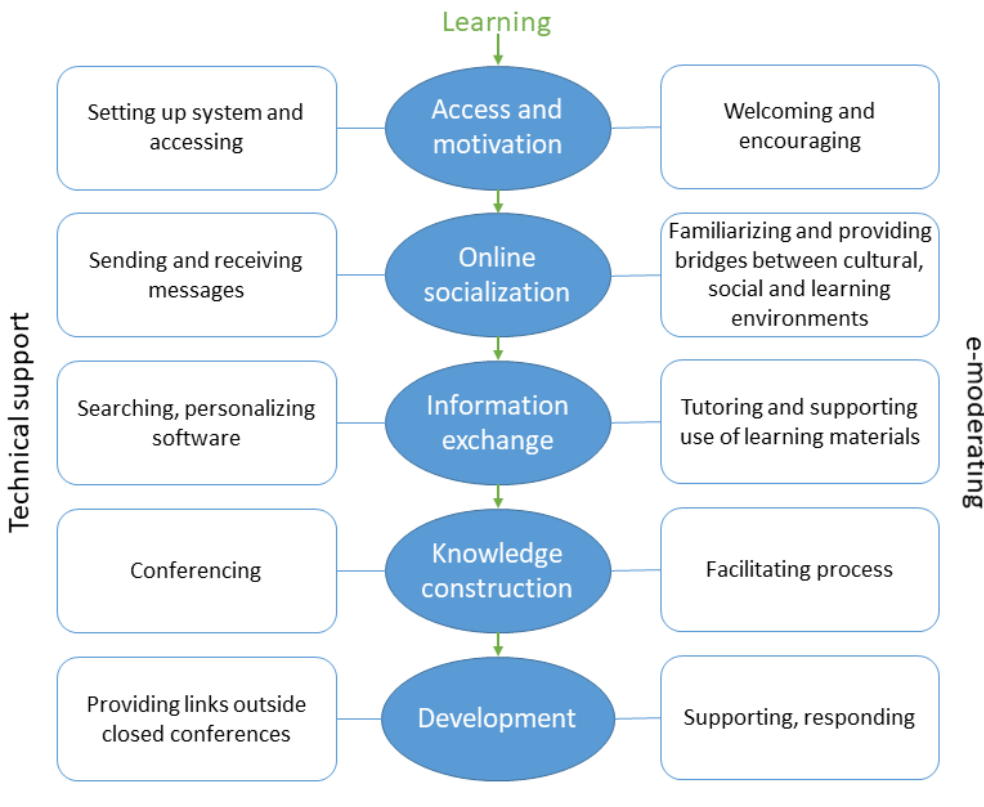
Figure 2. Five-stage model of e-moderating (after